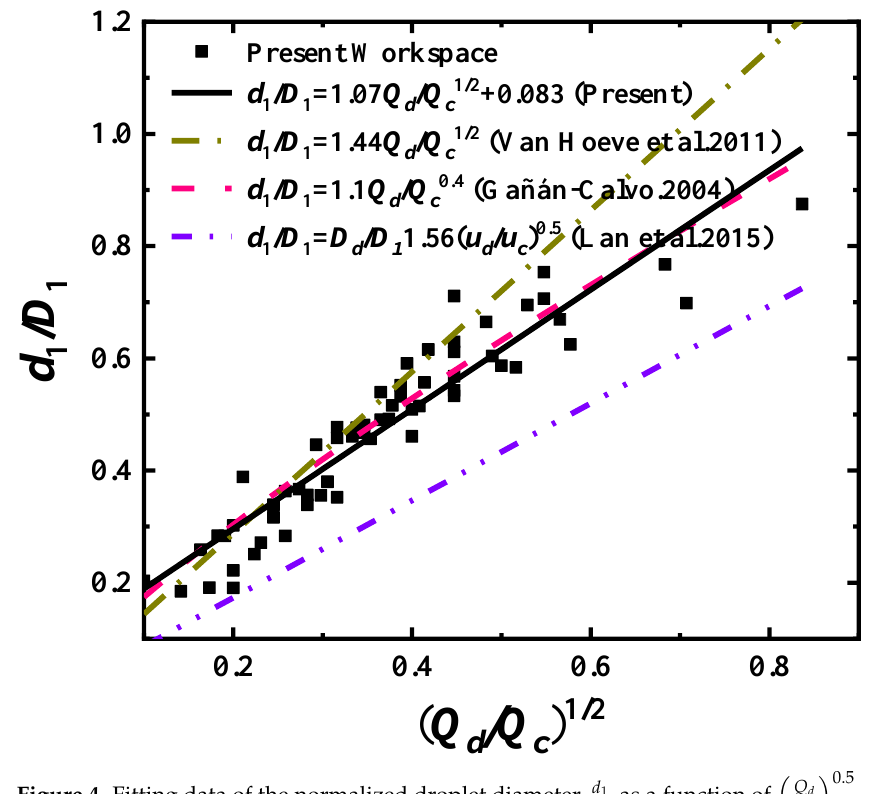
as a function of D 1